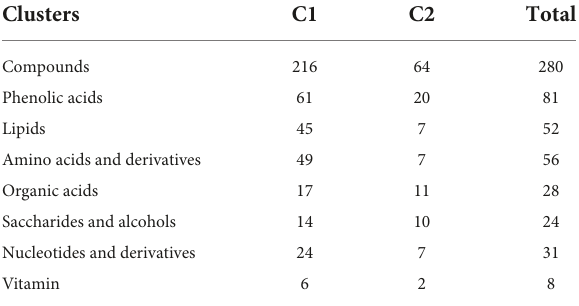
TABLE 1 Distribution of 280 primary metabolites identified between cluster 1 and cluster 2 based on